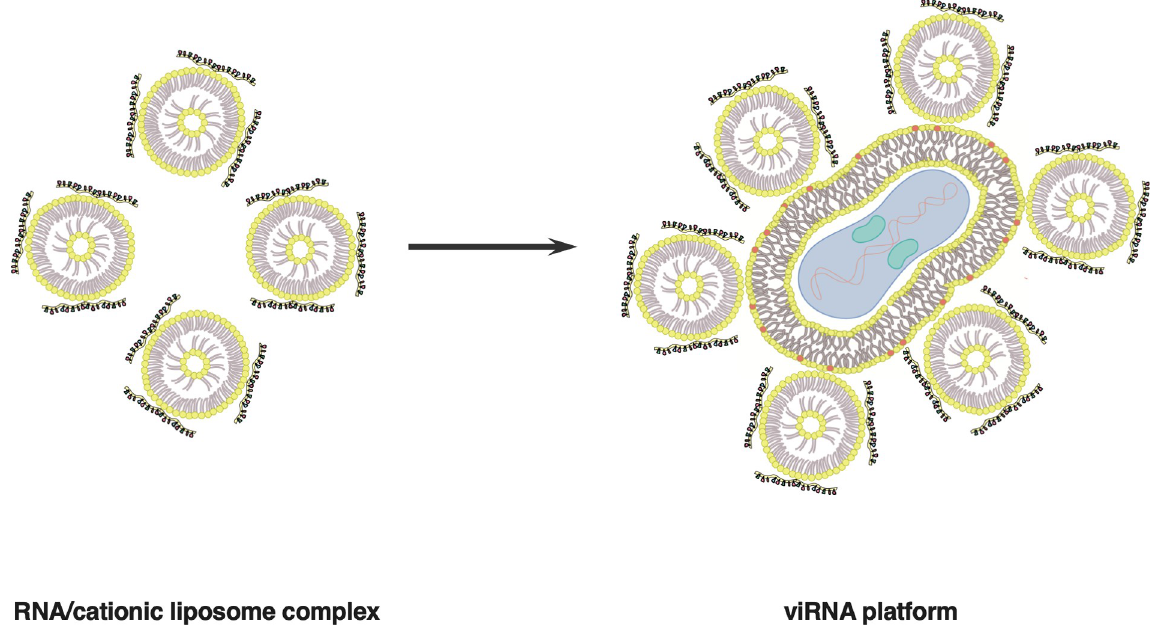
Fig 1. A schematic presentation of viRNA RNA-delivery platform. RNA molecules of various size and function can be attached onto enveloped viruses by using cationic liposomes. RNA molecules are first complexed with cationic liposomes and after the complex formation, the RNA/cationic liposome complex is mixed with enveloped virus to allow the attachment of the complex with the viral envelope. After attachment, viRNA complexes are purified for unbound RNA/cationic liposome complexes by centrifugation through 36% sucrose cushion for 1h at 20